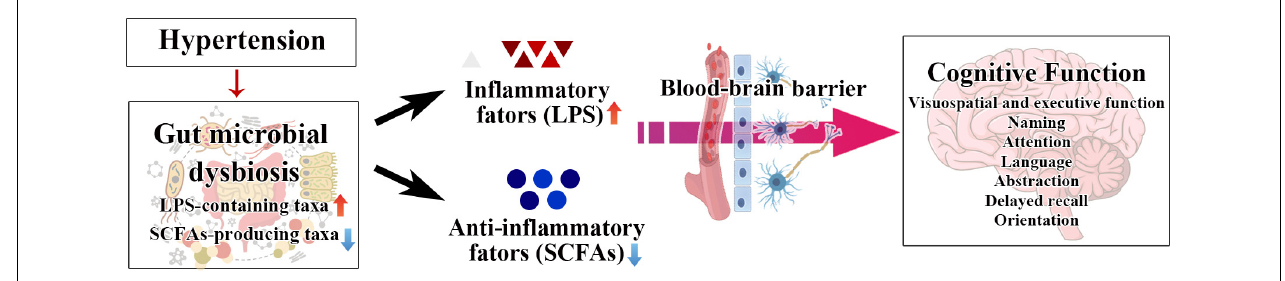
FIGURE 7 | The schematic diagram of our hypothesis about the relationship among SCFA, LPS, hypertension, and cognitive